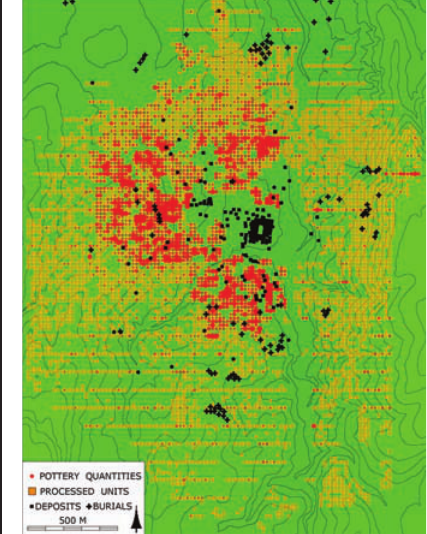
Figure 7 Prehistoric evidence, excavations and surface pottery counts.